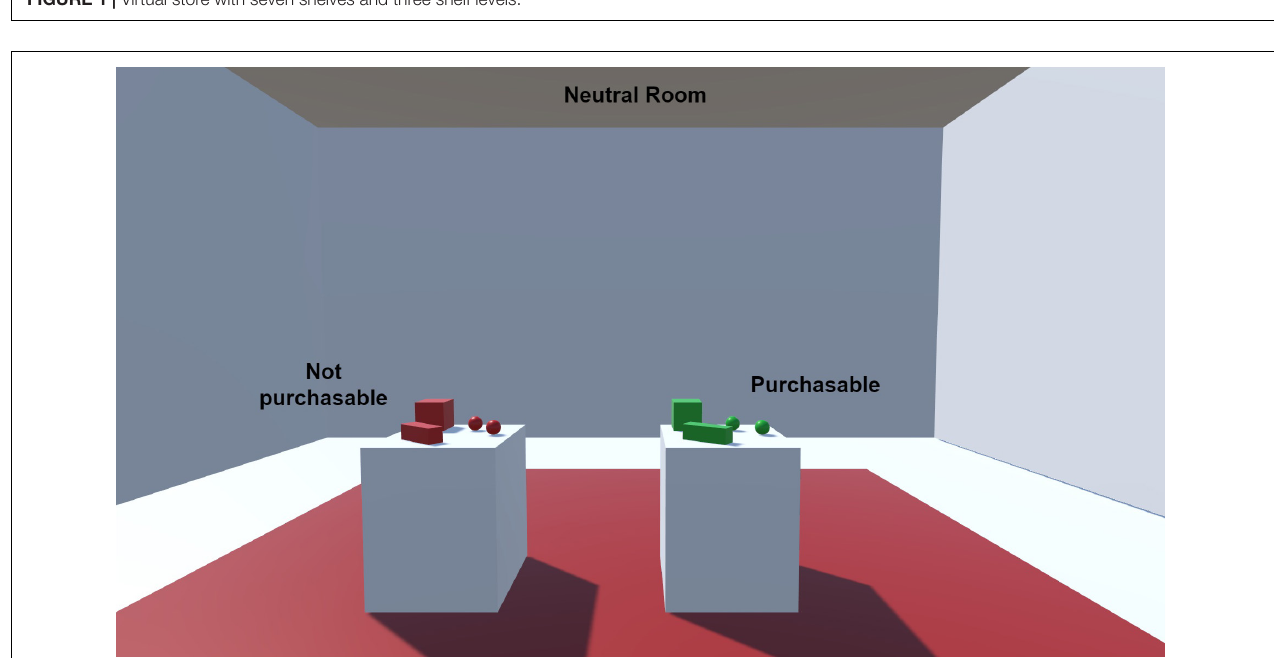
FIGURE 2 | Training room showing purchasable and non-purchasable